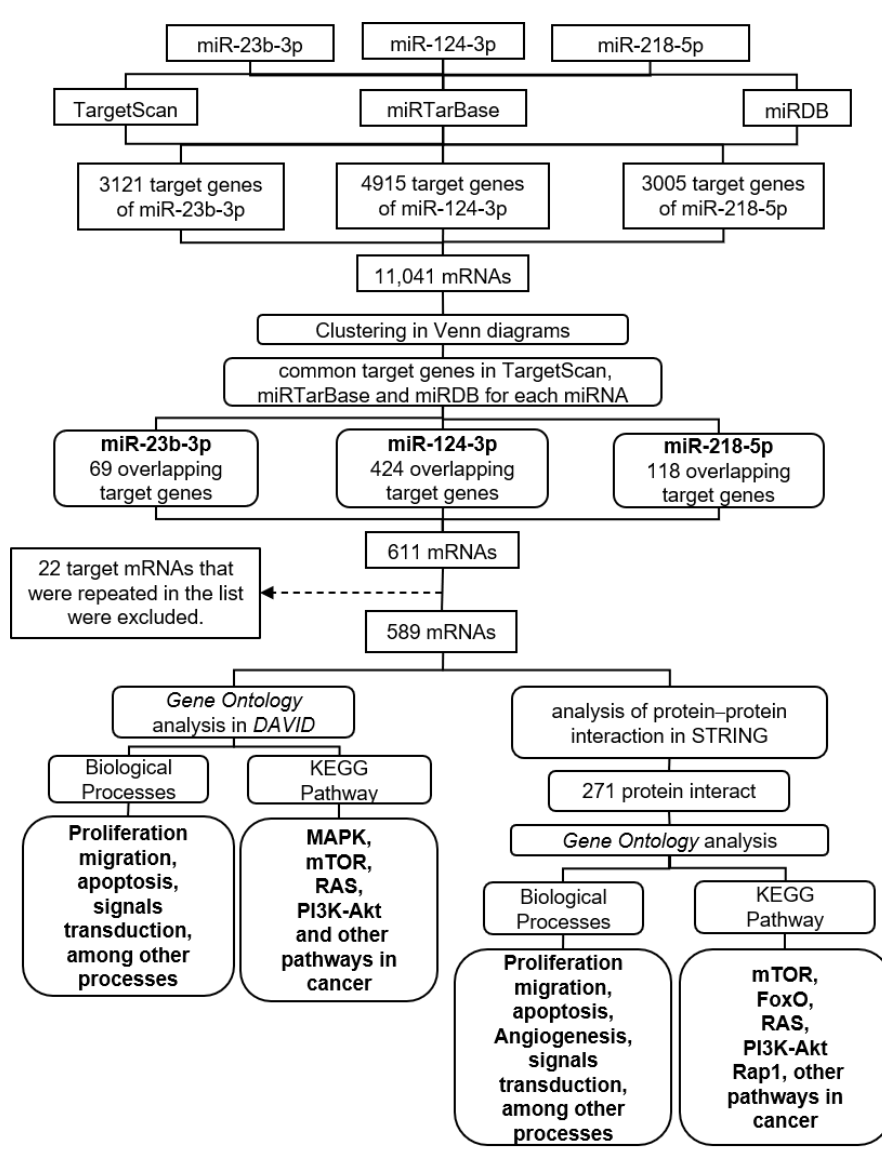
Figure 1. General flow diagram of the bioinformatics analysis for the identification of target genes of miR-23b-3p, miR-124-3p, and miR-218-5p, grouped and used for protein–protein interaction analysis and Gene Ontology. Table 2. Target mRNAs with MREs specific for miR-23b-3p, miR-124-3p, and miR-218-5p.